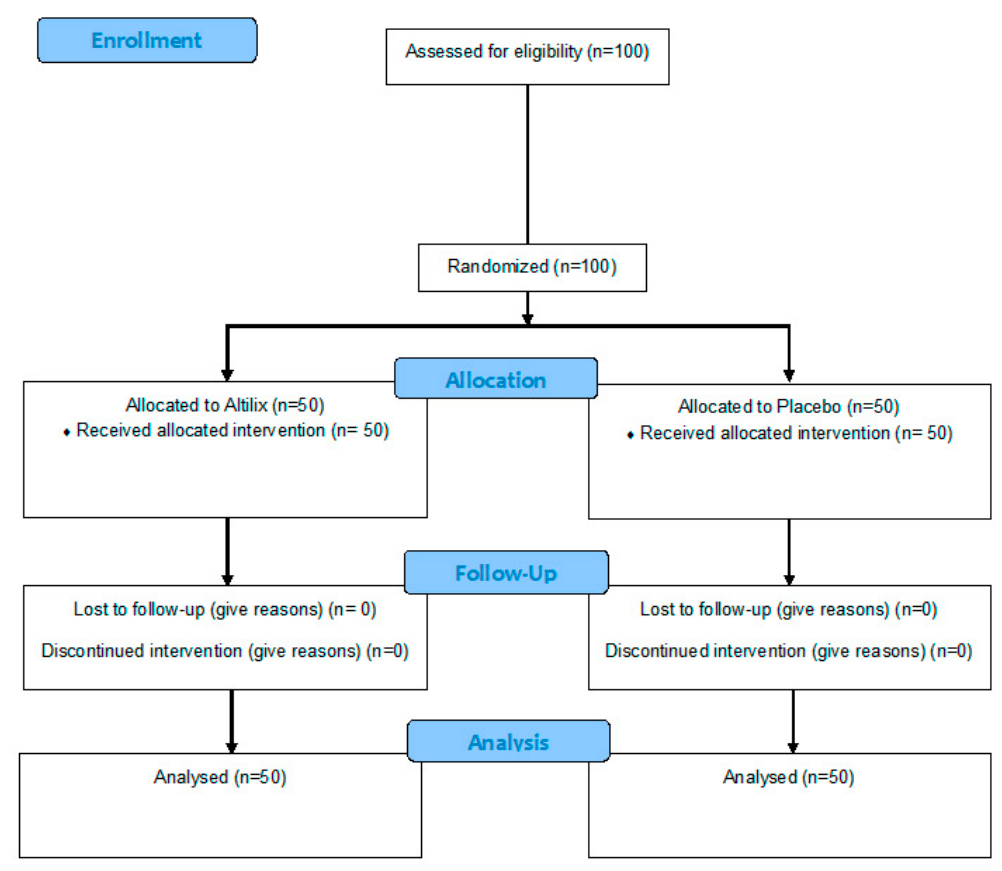
Figure 1. Flow diagram of study. Table 1. Baseline characteristics of all subjects included in the study ( n =